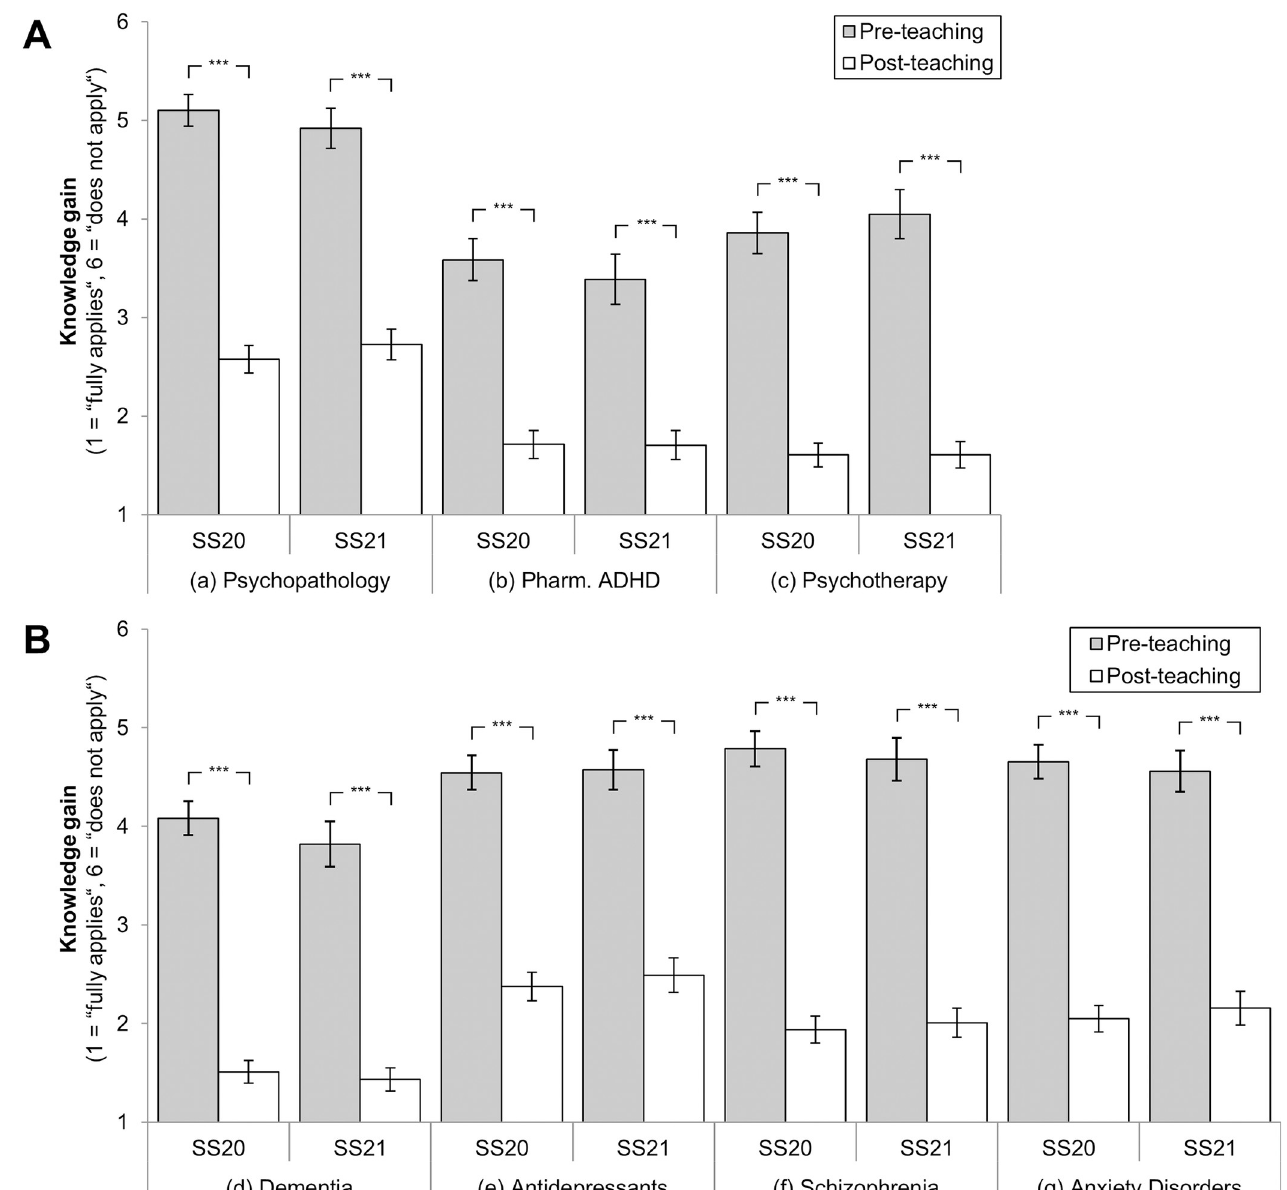
Fig 1. Knowledge gain in digital teaching, as rated by students in SS20 ( n = 175) and SS21 ( n = 136). � p < 0.05, �� p < 0.01, ��� p < 0.001. Mean values with 95%-CIs and Bonferroni corrected pairwise comparisons. Students rated statements retrospectively (pre-teaching) and post-teaching on a 6-stage scale (1 = “fully applies”, 6 = “does not apply”), e.g., “I know the different types of dementia” (please see S1 Table for all item formulations). N =